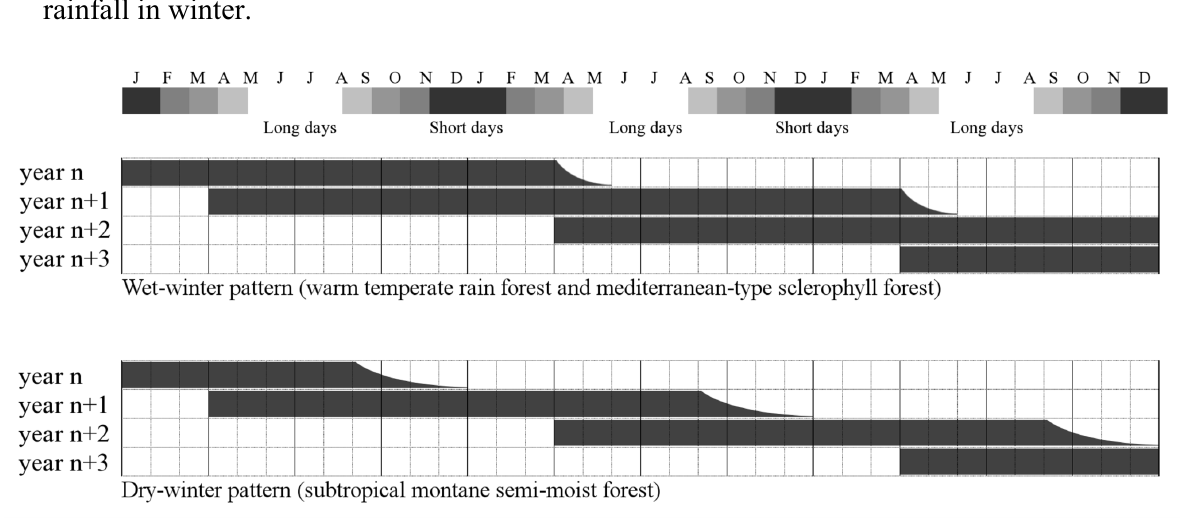
Figure 1. Theoretical patterns of seasonal change in the numbers of leaves in successive cohorts on evergreen trees with contrasting times of leaf fall related to different amounts of rainfall in winter.